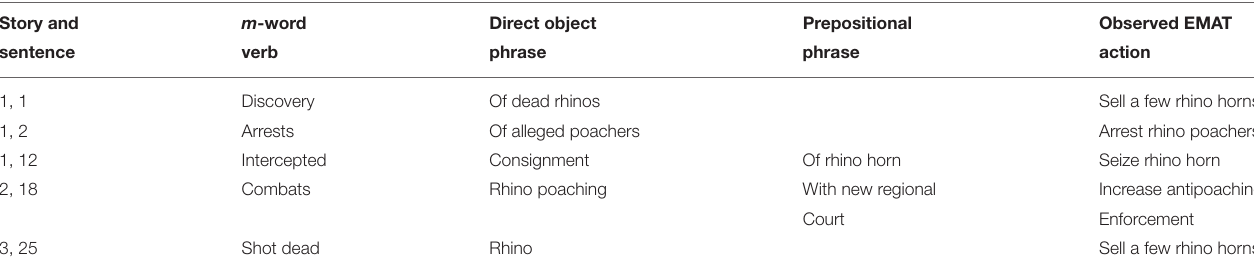
TABLE 1 | Sentence components found in Example 2’s three stories by the EMAT action extraction algorithm along with associated EMAT action observations. Story and